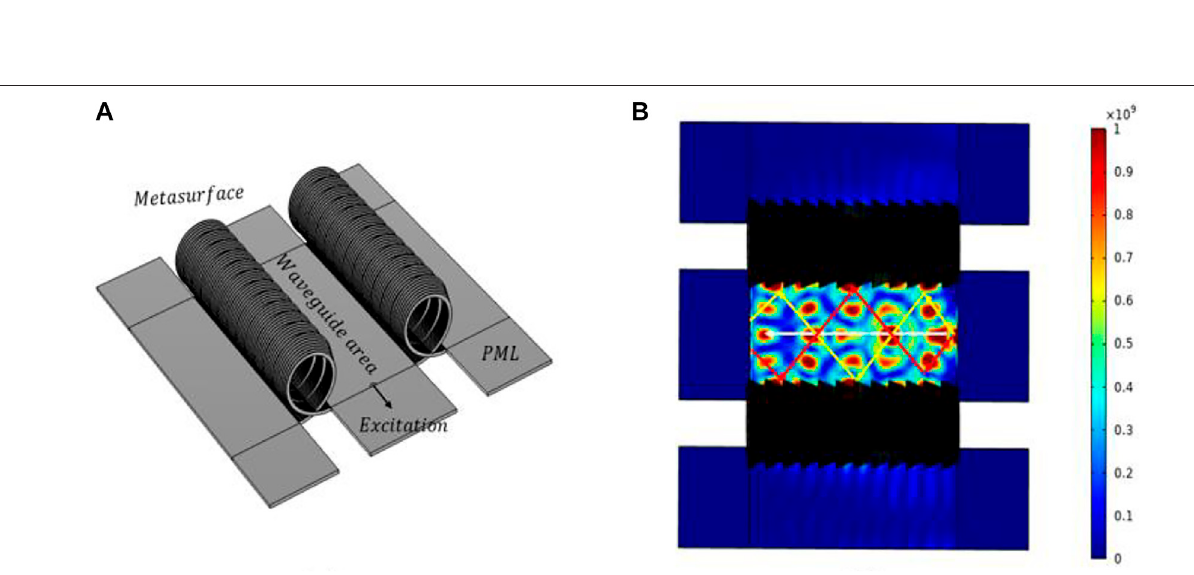
Frontiers in Physics |